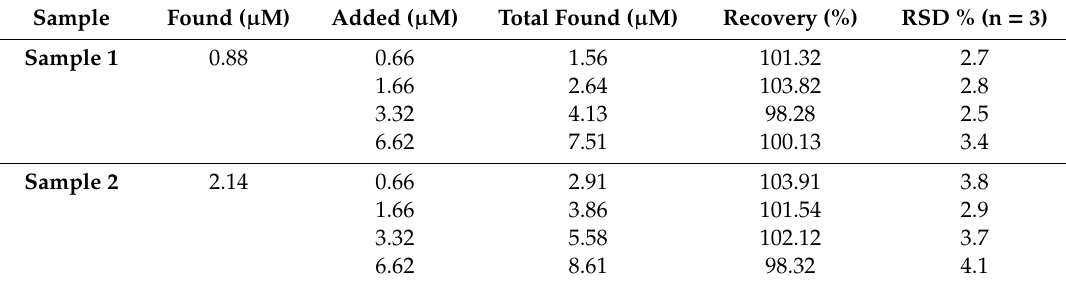
Table 2. Determination results of FA in orange drink samples (n = 3).